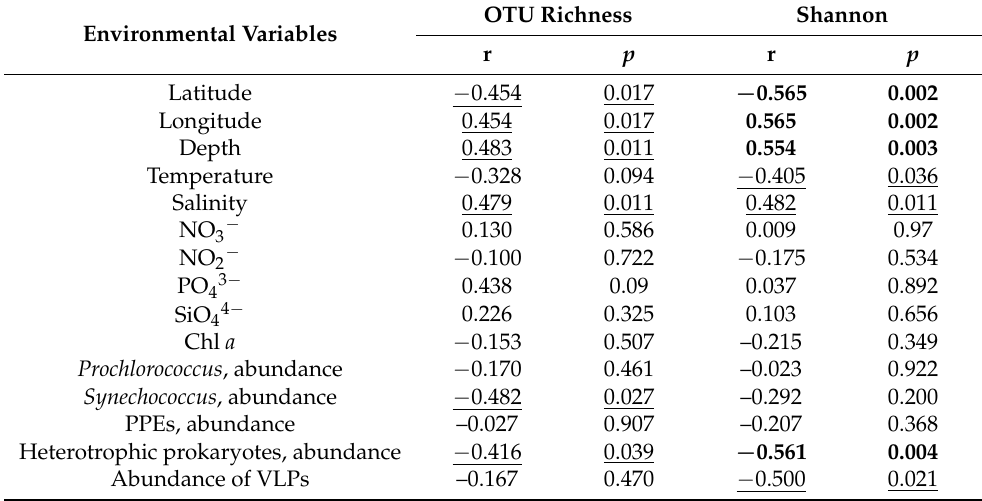
Table 2. Spearman’s correlation coefficients between alpha diversity estimates and environmental variables. When the correlation is significant both r- and p -values are underlined ( p < 0.05) or in bold ( p < 0.01).